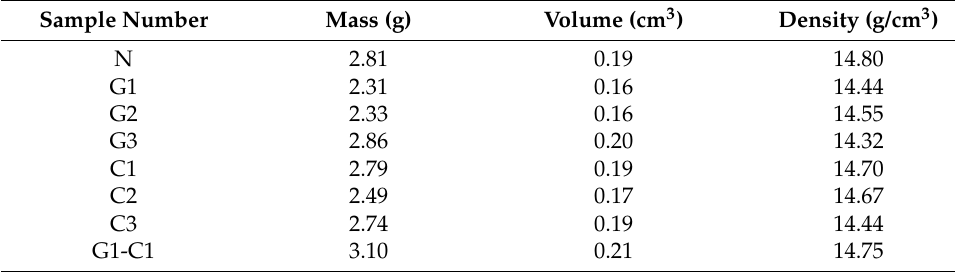
Table 6. Density of WC–Co cemented carbide.